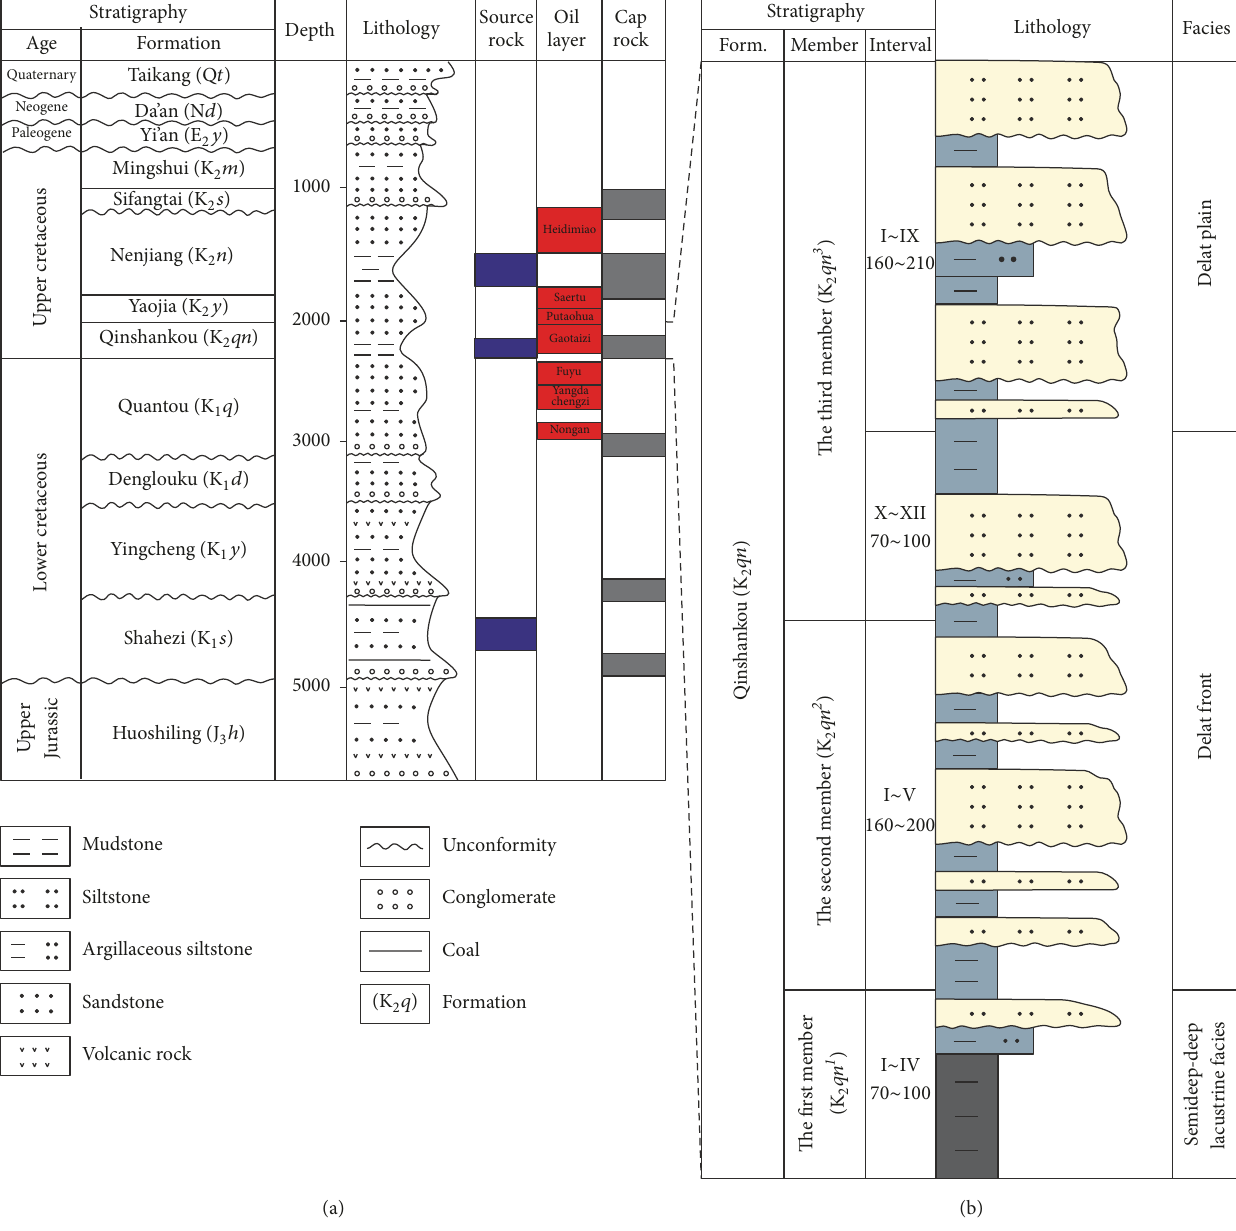
Figure 2: Stratigraphic column in Daqingzijing area. (a) Stratigraphy of the Songliao Basin. (b) Detailed stratigraphic characteristics of the Qingshankou Formation in the Daqingzijing area of the Songliao